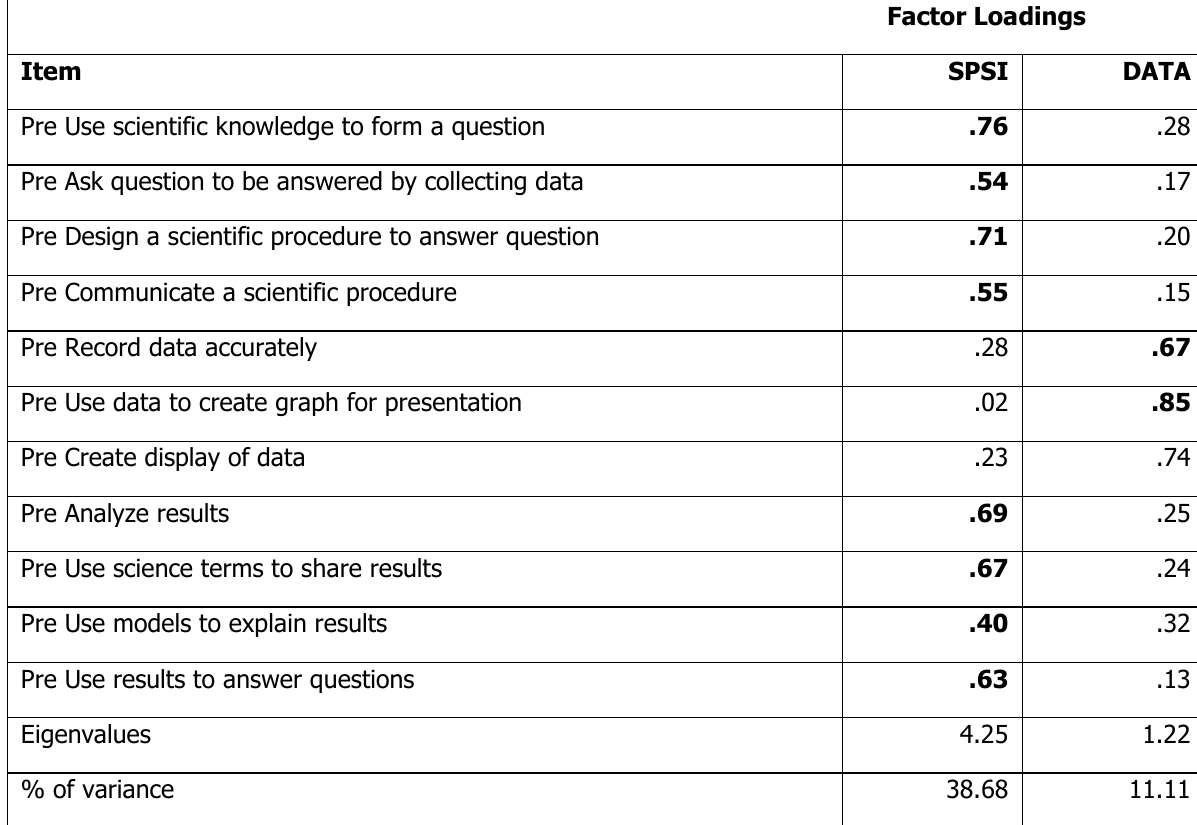
Summary of Exploratory Factor Analysis Results for Pre-test SPSI